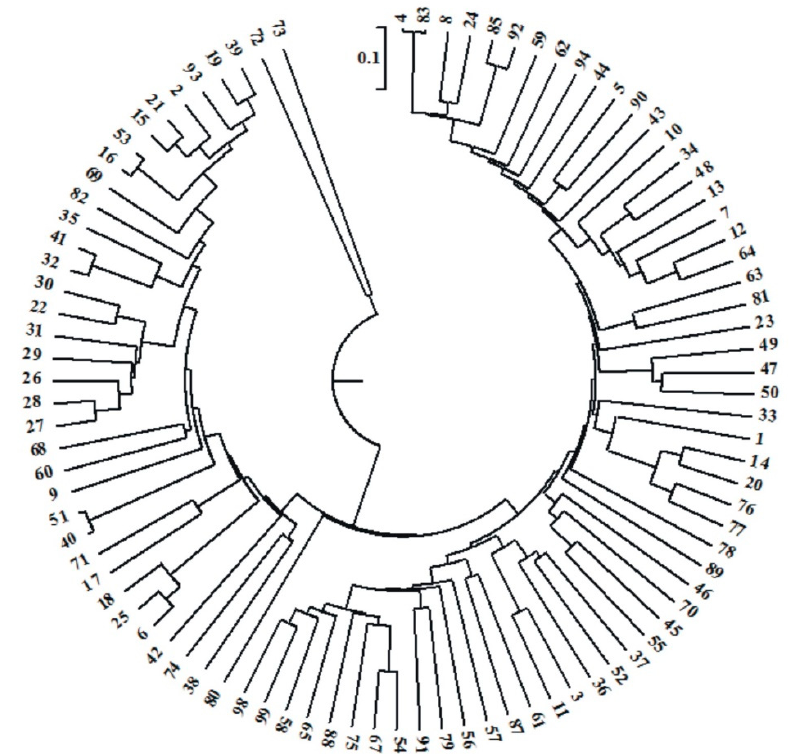
Figure 3. Dendrogram of genetic similarity of the studied inbred lines of maize ( Zea mays L.) on the basis of single-nucleotide polymorphism (SNP) and SilicoDArT marker